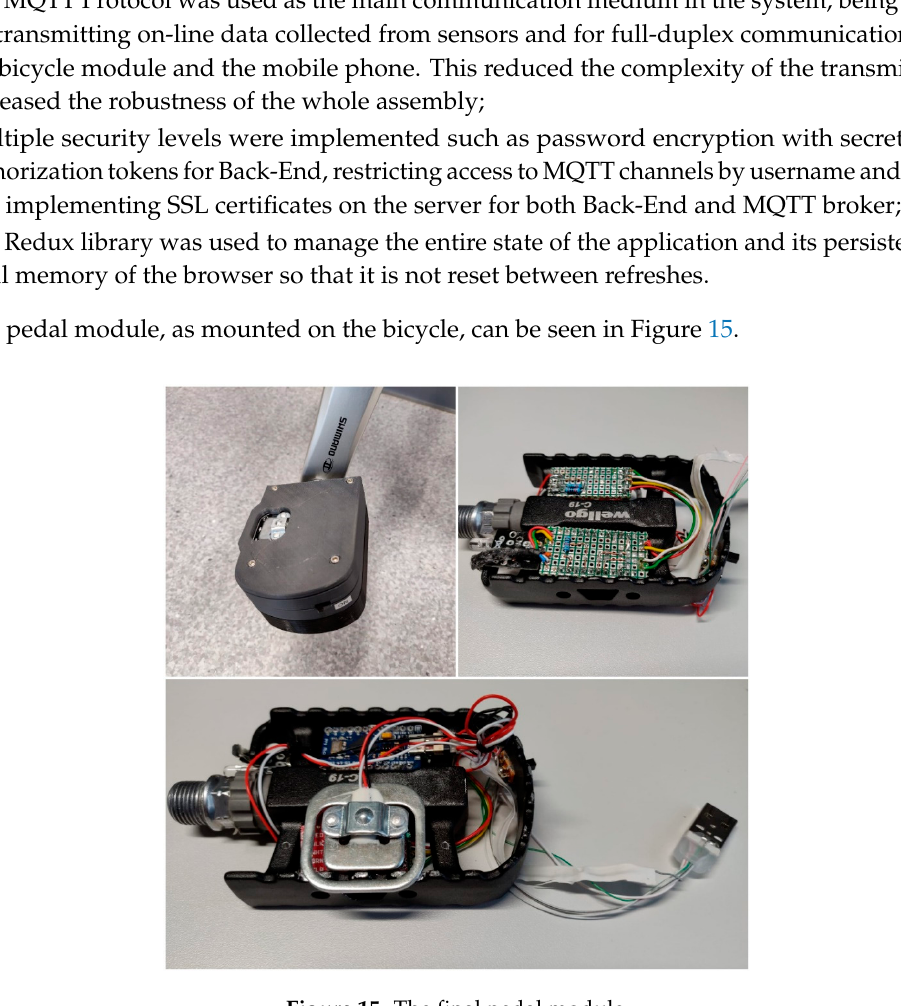
Figure 15. The final pedal module.